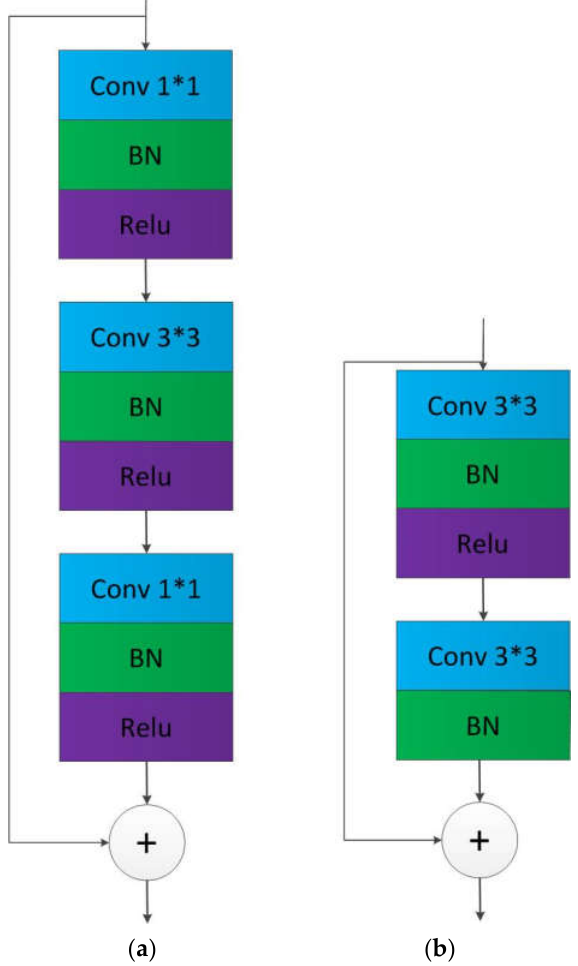
Figure 4. The architecture of the residual block. ( a ) The residual structure of the first stage. ( b ) The residual structure of the second, third, and fourth stages. Conv means a convolution operation, and × behind it means convolution kernel size. BN means batch normalization. Relu means activa- tion function.